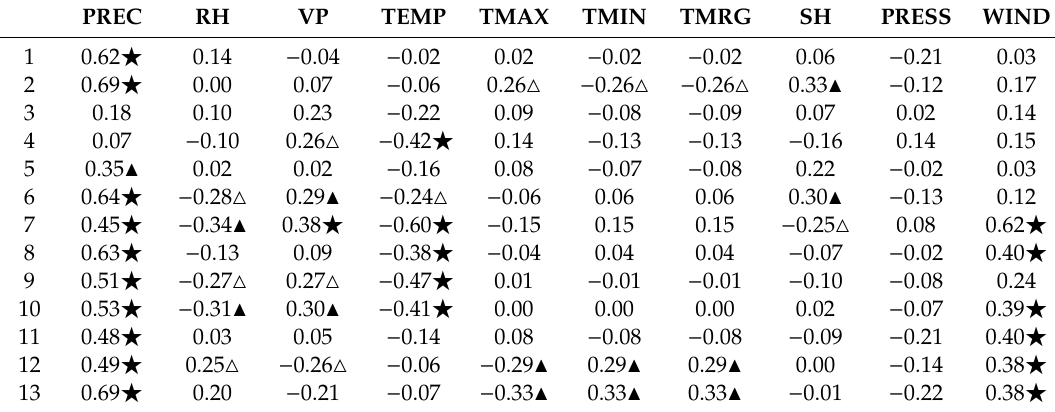
Table 5. Partial correlation coe ffi cients between climatic factors and the ETa at the sub-region scale in the Pearl River